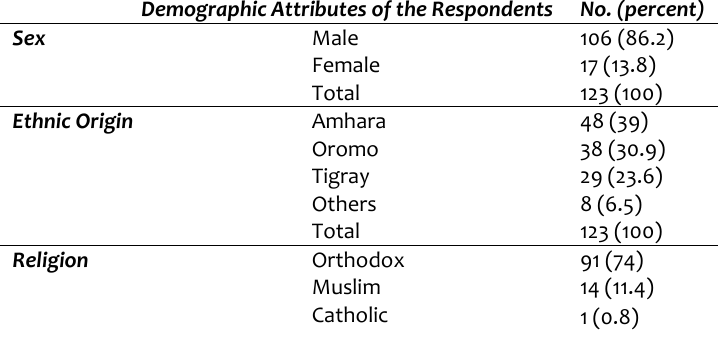
Table 2: Demographic Data of University